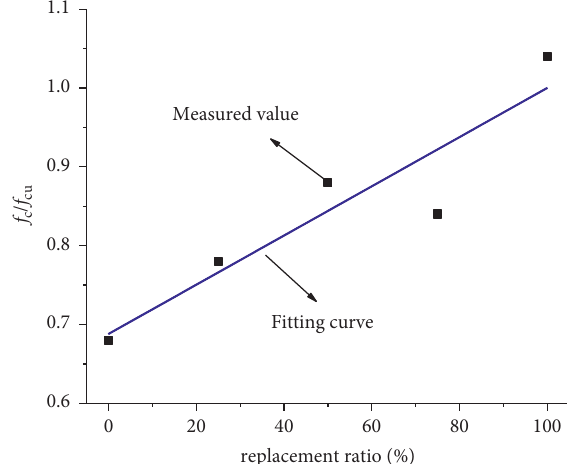
Figure 10: Different replacement ratios of f